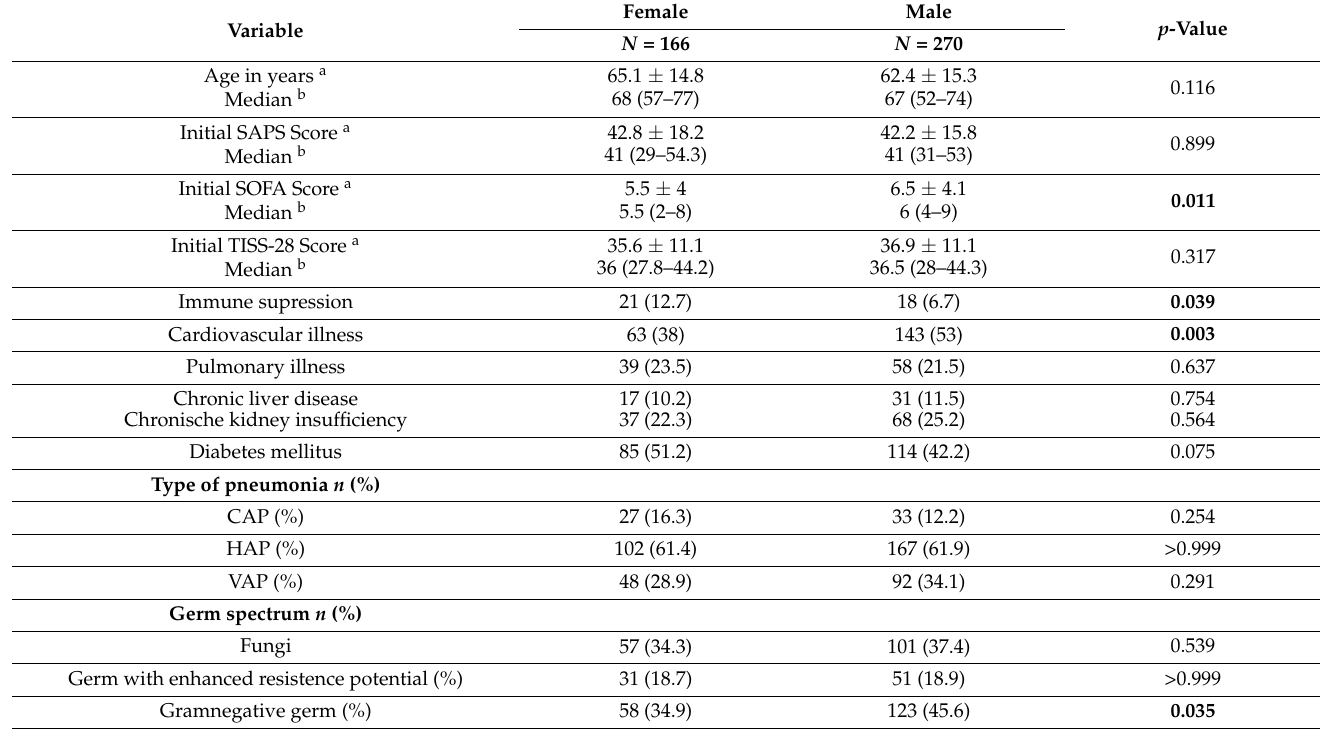
Table 1. Basic characteristics, distribution of preexisting illness and type of pneumonia.